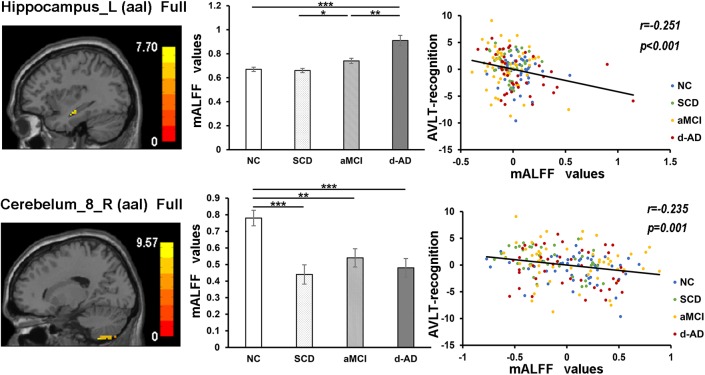
The correlation between mALFF values of the Hippocampus_L (aal) and Cerebelum_8_R (aal) in full band and recognition of AVLT scores. The column 1 showed corresponding anatomic location of the left hippocampus and Cerebelum_8_R (aal) in the brain. The column 2 displayed significant differences of mALFF values of these two regions in full band among four groups obtained by post hoc test (Bonferroni correction, P < 0.05). ∗ represents significant level P < 0.05; ∗∗ means significant level P < 0.01; ∗∗∗ means significant level P < 0.001. The column 3 were scatter plots demonstrating the negative correlation between the Hippocampus_L (aal) and Cerebelum_8_R (aal) and recognition of AVLT scores (Bonferroni correction, P < 0.05/5). Corresponding correlation coefficient “r” and significant level “p” were marked. NC, normal controls; SCD, subjective cognitive decline; aMCI, amnestic mild cognitive impairment; d-AD, dementia of Alzheimer’s disease; mALFF, the normalized amplitude of the low-frequency fluctuation; AVLT, the auditory verbal learning test.